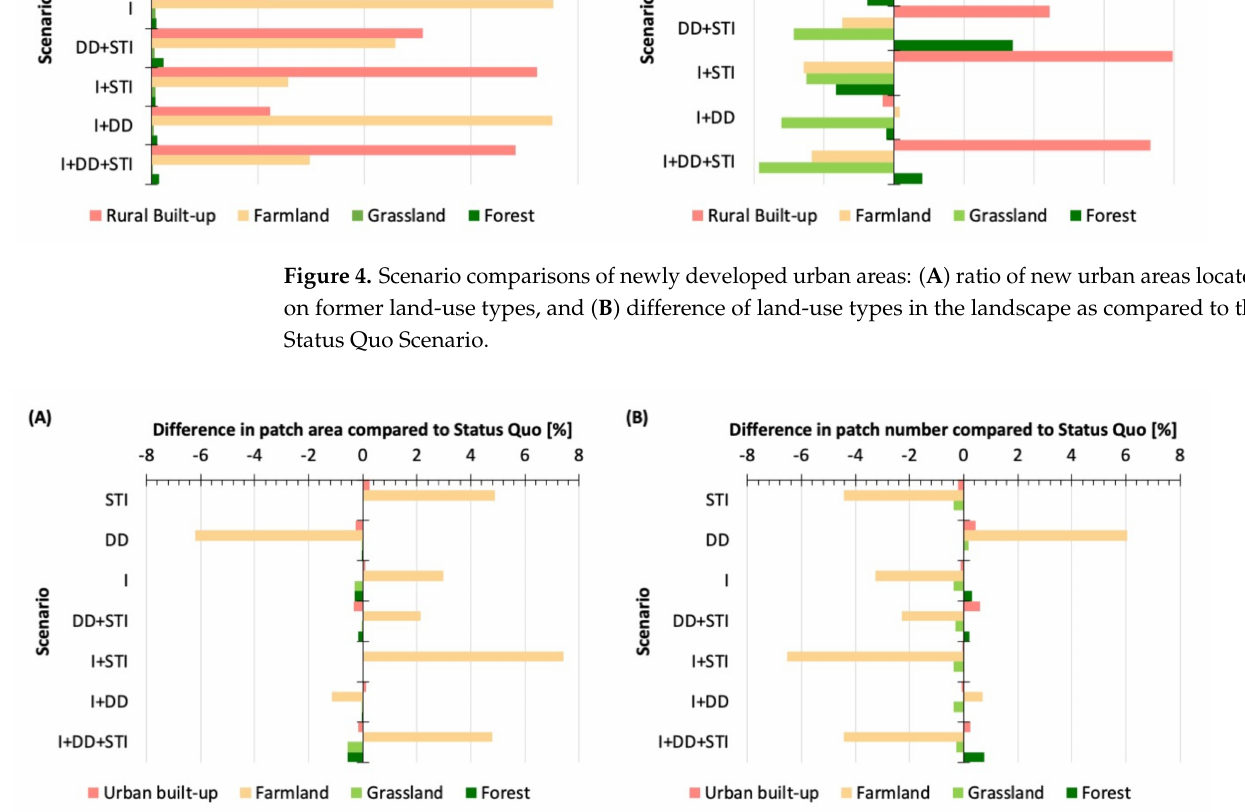
Figure 5. Fragmentation metrics for the different land-use types under different scenarios compared to the Status Quo Scenario: ( A ) patch area, and ( B ) patch